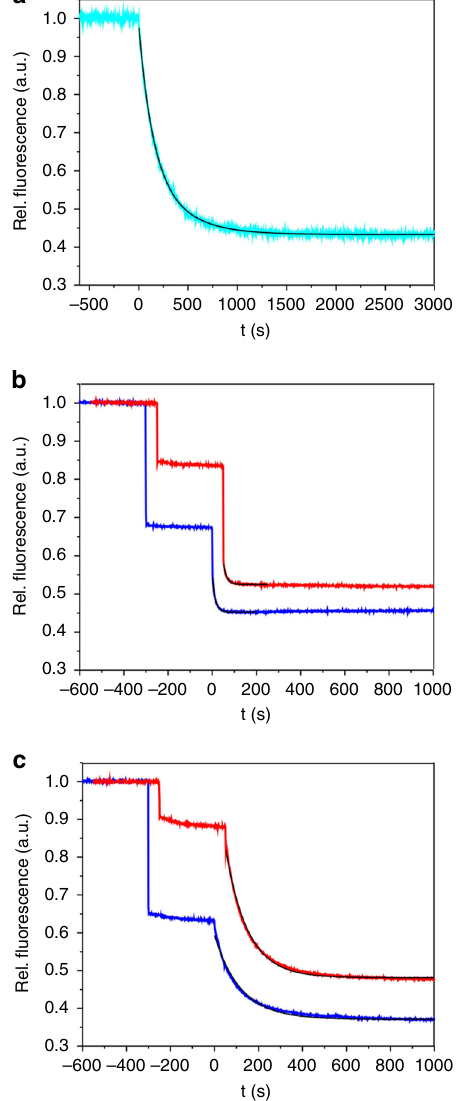
Fig. 8 Kinetics of lid closure of Hsp90 and its modulation by Aha-type co- chaperones. a Time course of PET fl uorescence quenching of fl uorescently modi fi ed Hsp90 mutant S51C-A110W (cyan). The non-hydrolyzable ATP analog AMP-PNP, which traps Hsp90 in the closed-clamp conformation, was added at time t = 0. The black line is a fi t to a bi-exponential decay function. b Same experiment as shown in a but Aha1p (blue line) or Aha1p Δ 11 (red line) was added 300 s prior to addition of AMP-PNP. Black lines are fi ts to exponential decay functions. c Same experiment as shown in a but Hch1p (blue line) or Hch1p Δ 11 (red line) was added 300 s prior to addition of AMP-PNP. Black lines are fi ts to exponential decay functions. Data sets of Aha1p Δ 11 and of Hch1p Δ 11 are offset along the x -axis for reasons of clarity